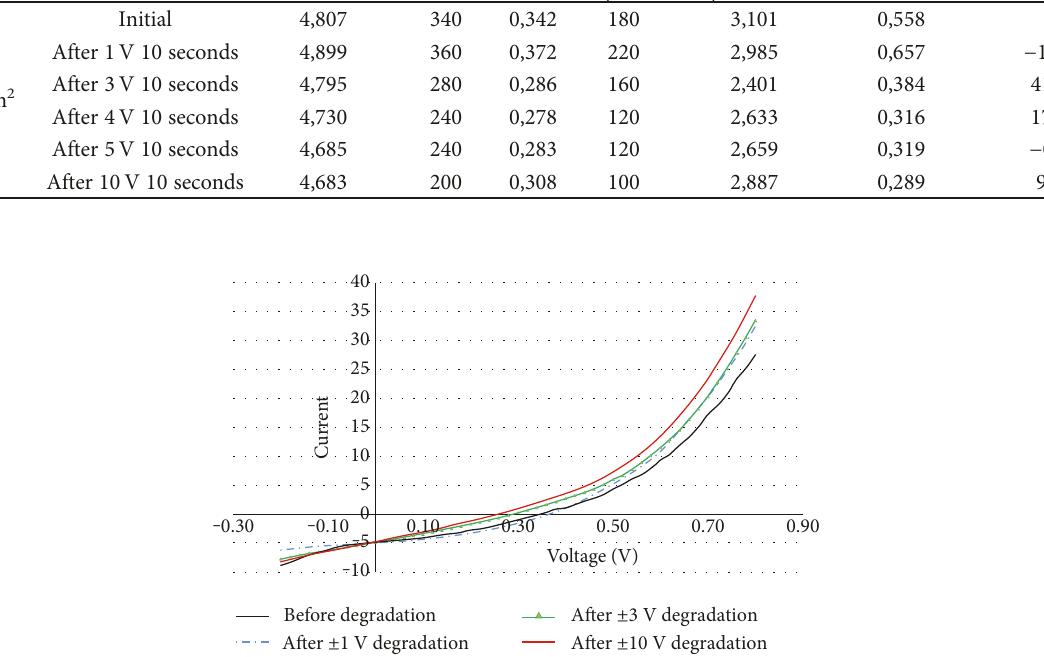
Table 2: Device 4 fi nger 1 voltage-dependent degradation with 10-second time intervals. Light intensity